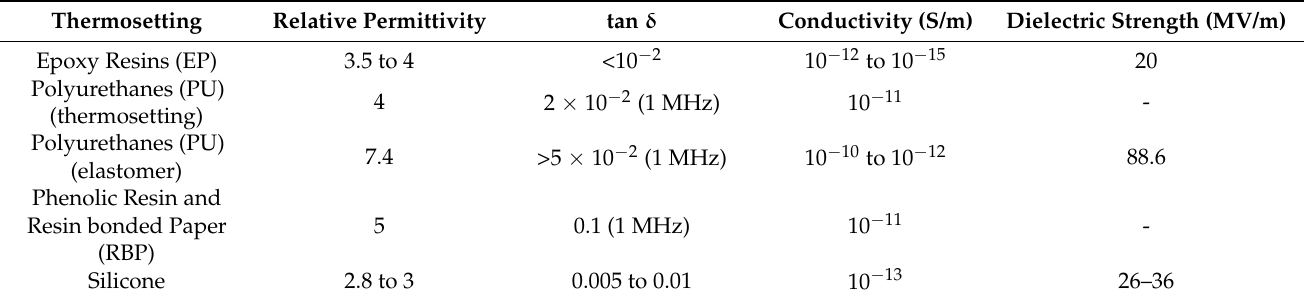
Table 6. Overview of thermosetting and elastomer insulating materials